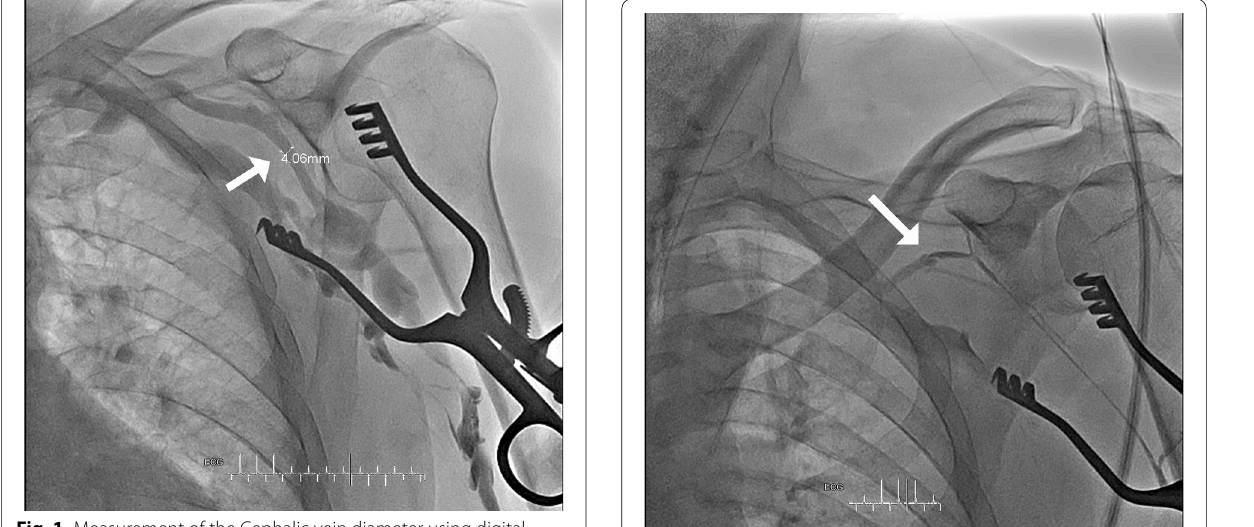
Fig. 1 Measurement of the Cephalic vein diameter using digital subtraction angiography DSA (white arrow)